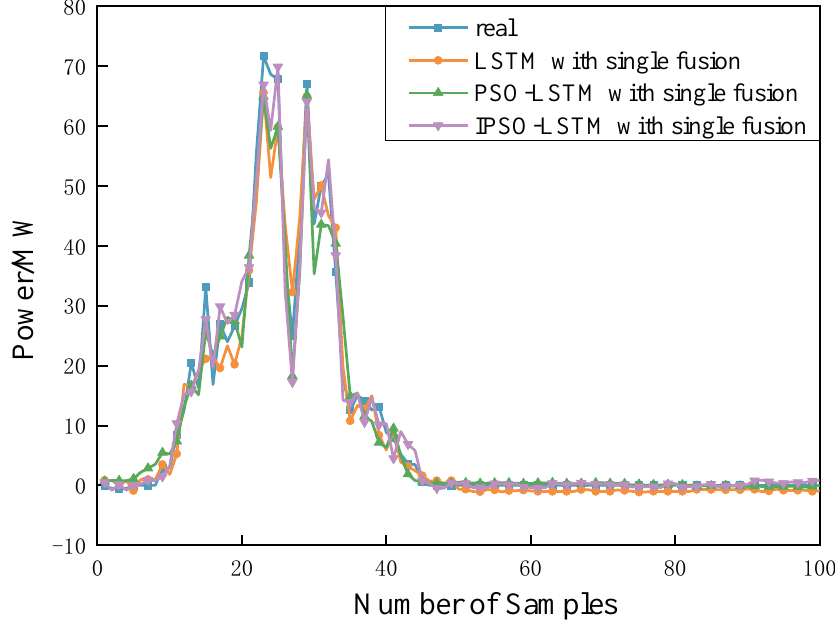
Figure 11. Predicting results of different models in a single fusion pattern.